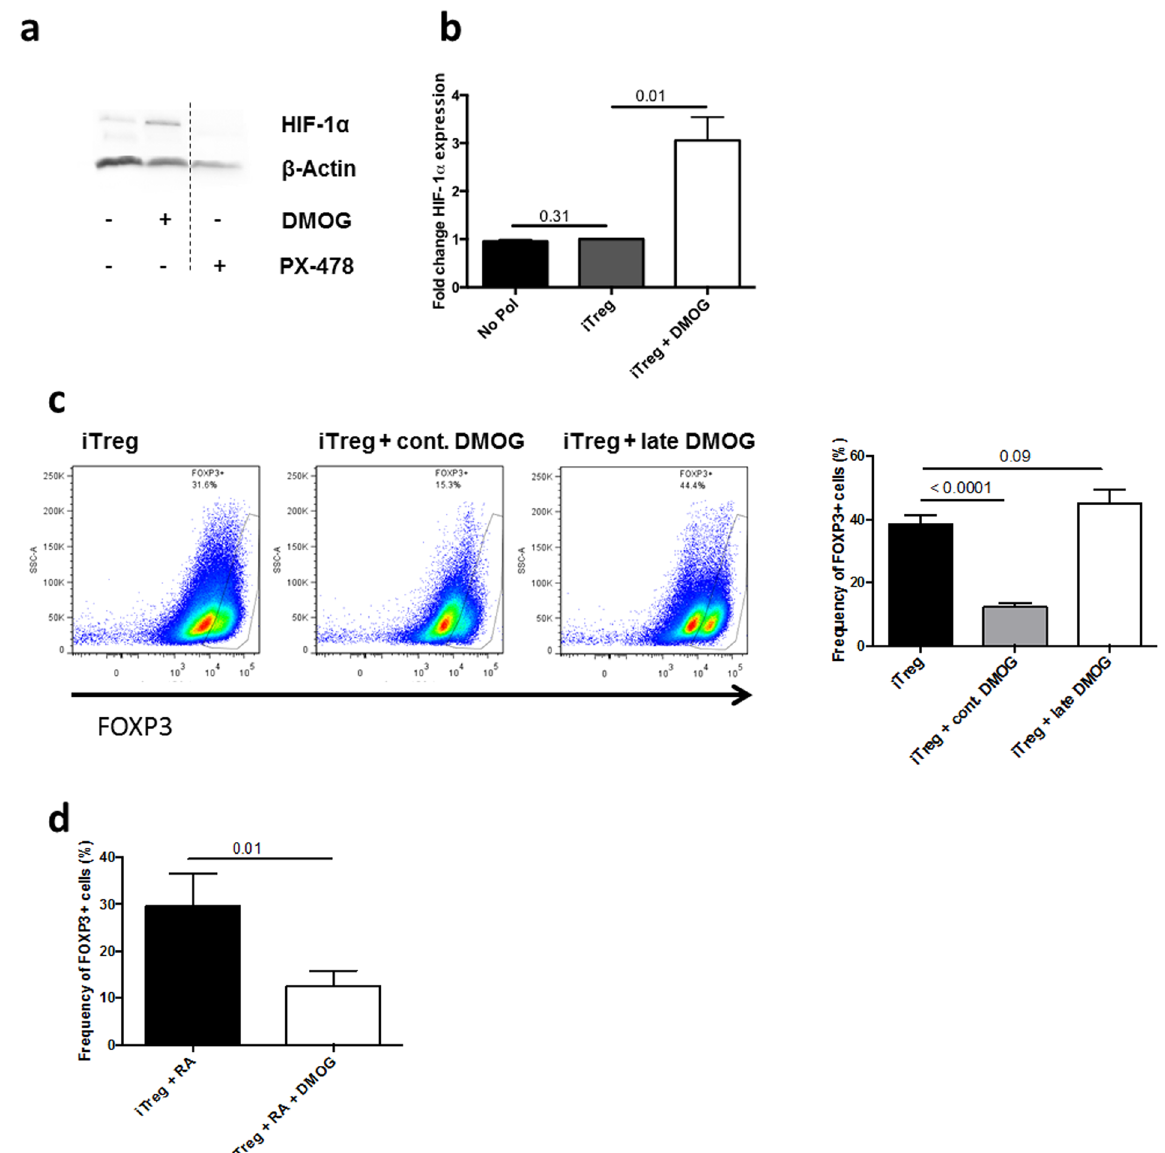
Figure 4. HIF-1 α induction by DMOG abrogates iTreg differentiation. ( a ) Representative WB analysis of HIF-1 α expression at d3 of Treg polarization in presence or absence of DMOG (100 μ M) and PX-478 (10 μ M). ( b ) Mean ( ± SEM) fold change in WB HIF-1 α expression in unpolarized CD4 + cells (unpol) or iTreg, cultured in absence or presence of continuous DMOG (added every 2 days for 6 days). ( c ) Left Panel: representative FACS dot plots of FOXP3 + CD4 + cells at d6 of iTreg polarization, with and without DMOG. Right panel: mean ( ± SEM) frequency of FOXP3 + cells in presence or absence of DMOG (n = 12). DMOG was either continuously present (cont. DMOG) or added 3 days after culture initiation (late DMOG). ( d ) Mean ( ± SEM) iTreg frequency in cells polarized in presence of retinoic acid (RA) (100 nM), in absence or presence of continuous DMOG (n = 6). P-values correspond to paired